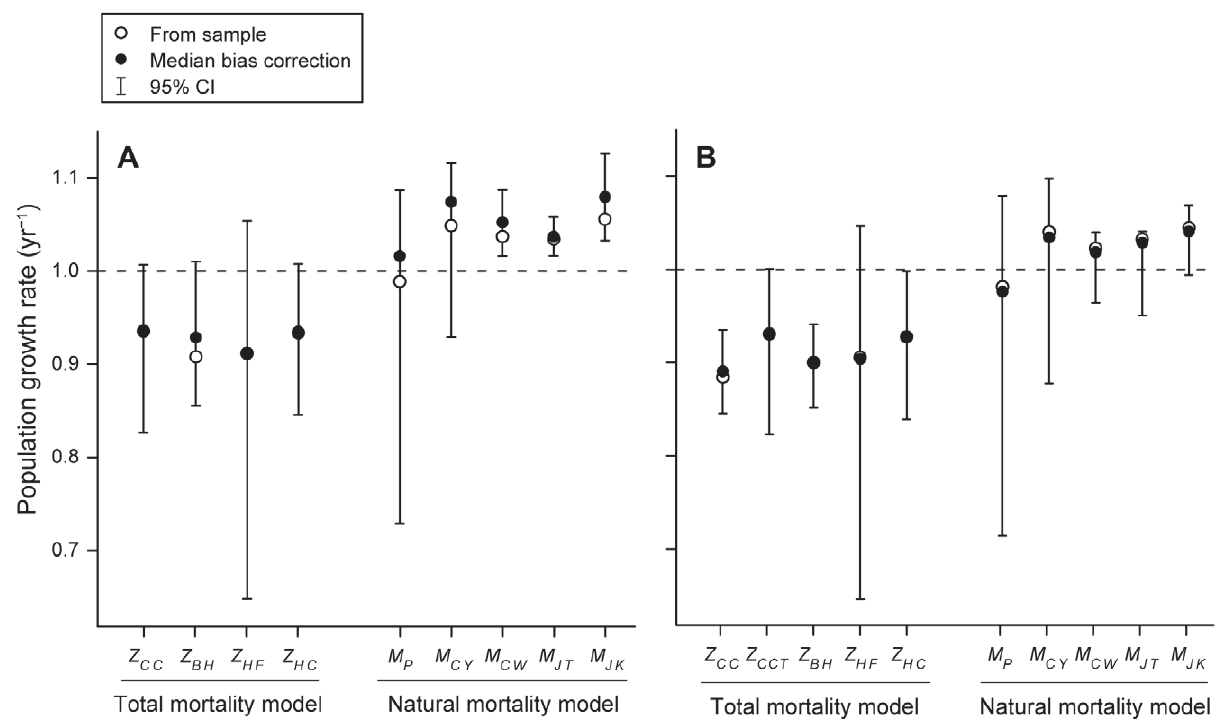
Figure 3. Estimates of natural and total population growth rate for two reef shark species. These estimates were calculated for (A) T. obesus and (B) C. amblyrhynchos on the Great Barrier Reef. For each method, an open circle indicates the (raw) sample estimate, which was obtained using maximum likelihood parameter estimates from analysis of the empirical data, a closed circle indicates the bootstrap bias-corrected estimate, and whiskers indicate 95% bias-corrected, accelerated (BCa) bootstrap confidence intervals. Dashed lines indicate the threshold between population growth (above) and decline (below).